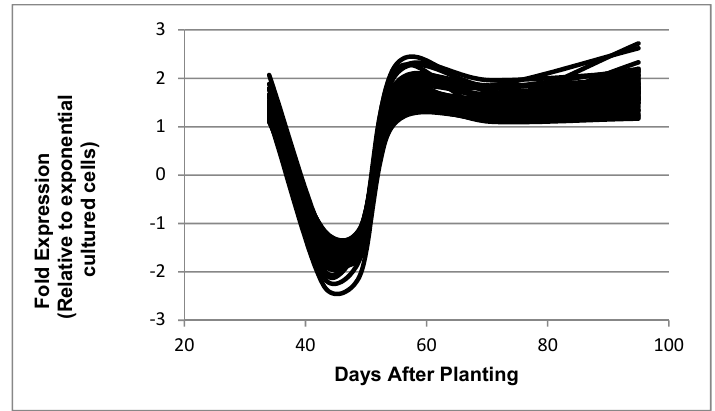
Figure 7. Expressed genes representing the reciprocal symbiosis pattern. The 68 genes shown in the figure are: bll0116, bll0195, bll0776, bll0979, bll1109, bll1422, bll2116, bll2410, bll2494, bll2675, bll3374, bll3444, bll3470, bll3505, bll3783, bll4141, bll4201, bll4403, bll4596, bll4793, bll5240, bll5296, bll5959,